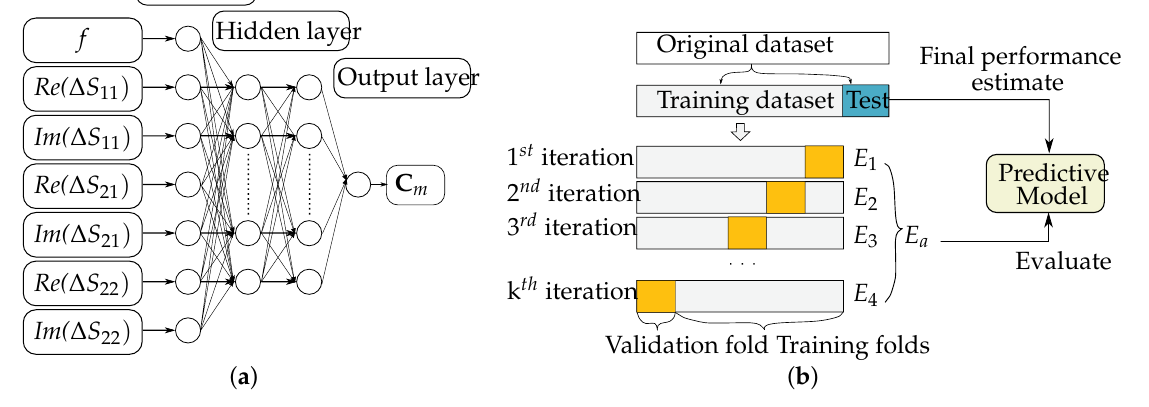
Figure 12. Overview of the signal post-processing redrawn according to [32]. ( a ) Structure of the applied neural network. ( b ) Structure of the applied cross validation. Table 6. Performance comparison of recently published earlobe models, concerning analytical as well as neural network approaches such as Complex-Valued Neural Networks (CVNN). Cal. corresponds to